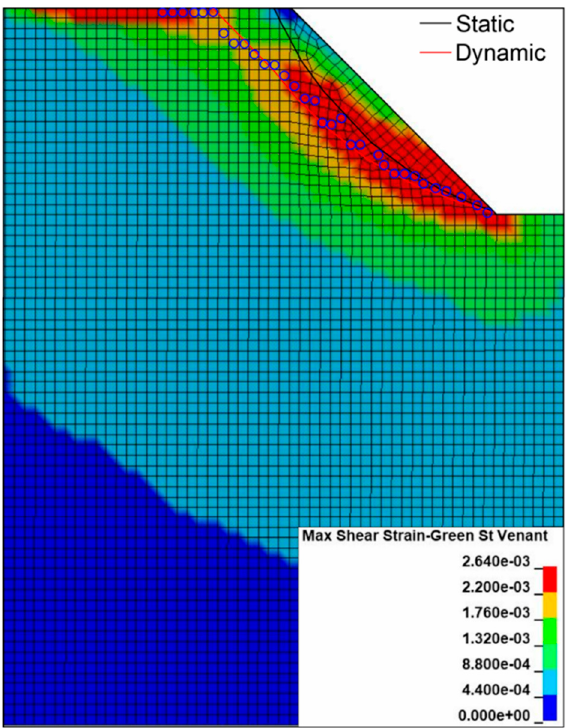
Figure 7. Determination of critical failure surface for Case 11 and Ofunato motion scaled to PGA = 0.25 g.